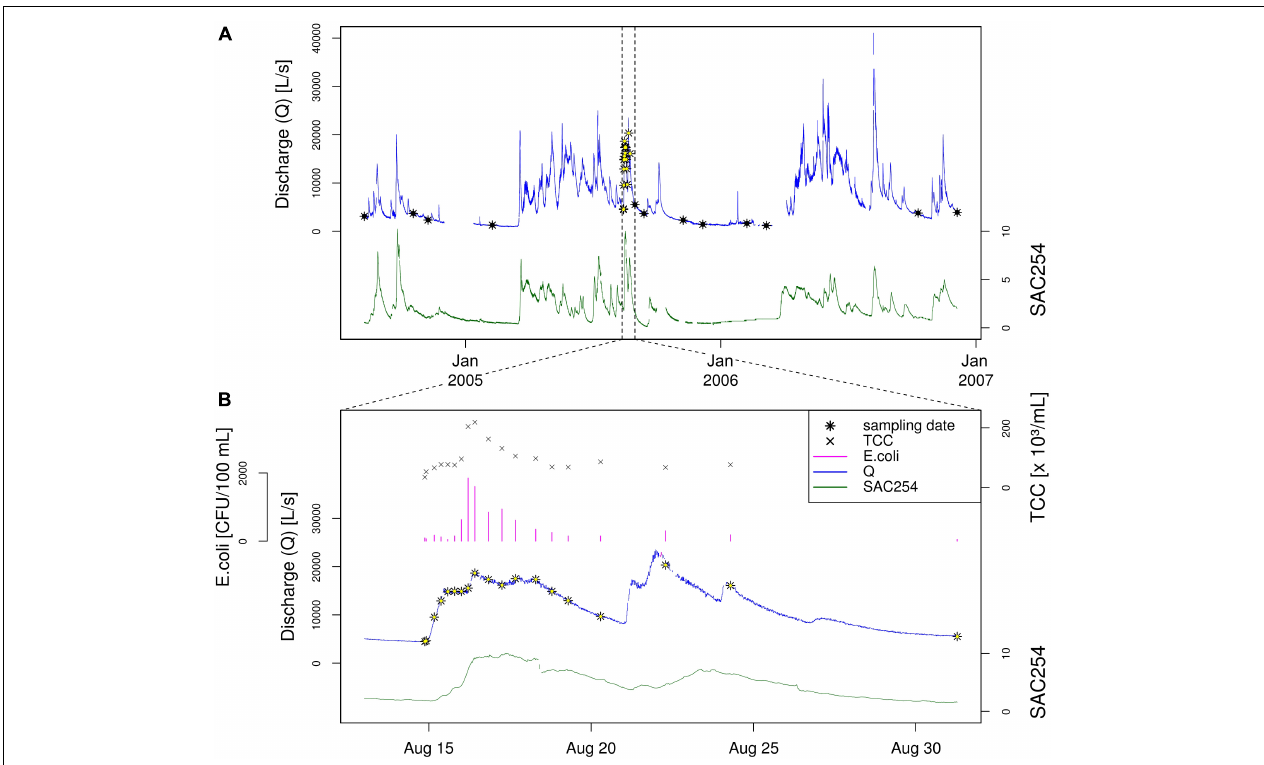
FIGURE 1 | Study design. Timeline showing the sampling dates (black and black-yellow stars) along the discharge graph (blue) as well as the measured Spectral Absorption Coefficient at λ = 254 nm (SAC 254 ; green) for (A) the entire sampling period, and (B) the investigated high-discharge event in August 2005. Panel (B) additionally depicts total cells counts (TCC) as well as concentrations for the standard fecal pollution indicator E. coli . Data on E. coli concentrations, discharge and SAC 254 were previously published by Reischer et al.